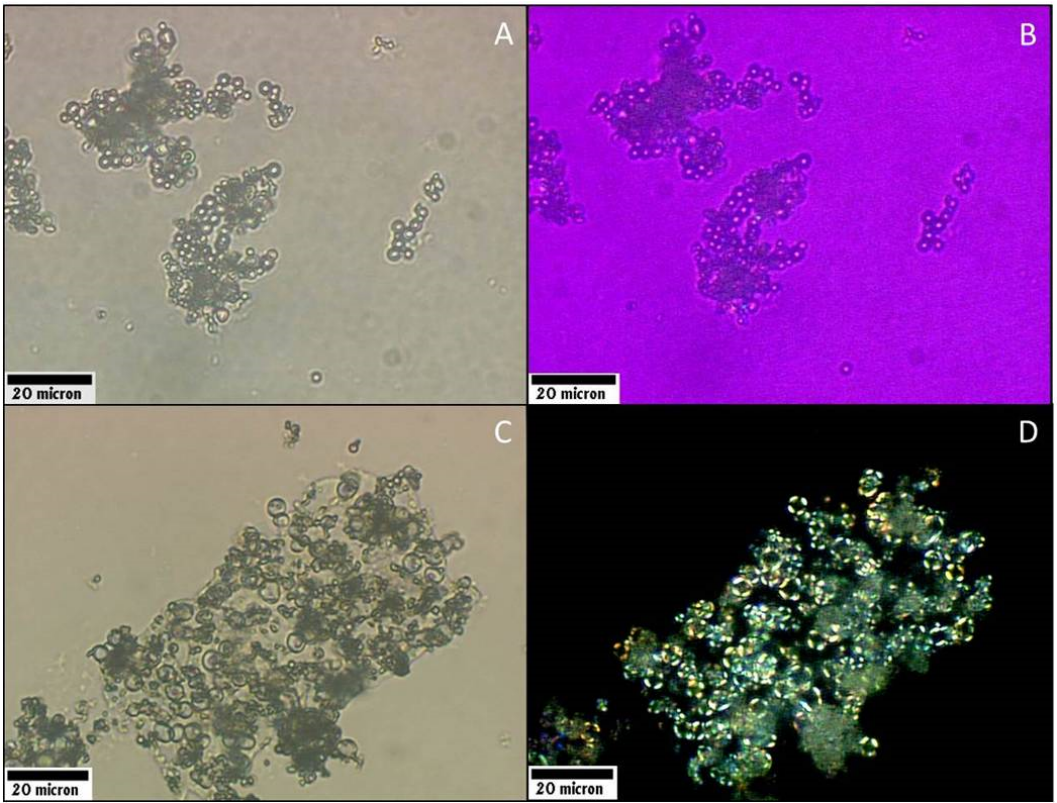
Figure 5 . Tailoring the crystallinity of the microcapsules. The images on the left are optical micrographs, while the images on the right are using polarized light. ( A , B ) Microcapsules generated using a 2.5:1 ratio of Ca/Mg display birefringence, indicating crystallinity. ( C , D ) Microcapsules generated using a 5:1 Mg/Ca ratio lack birefringence, indicating that the mineral remains amorphous under these conditions. A gypsum waveplate was used for image B, giving a magenta (1st-order red) background, because the amorphous particles lack birefringence and are, therefore, difficult to see under crossed-polars. If they were birefringent, one would see higher order interference colors (such as orange and blue).